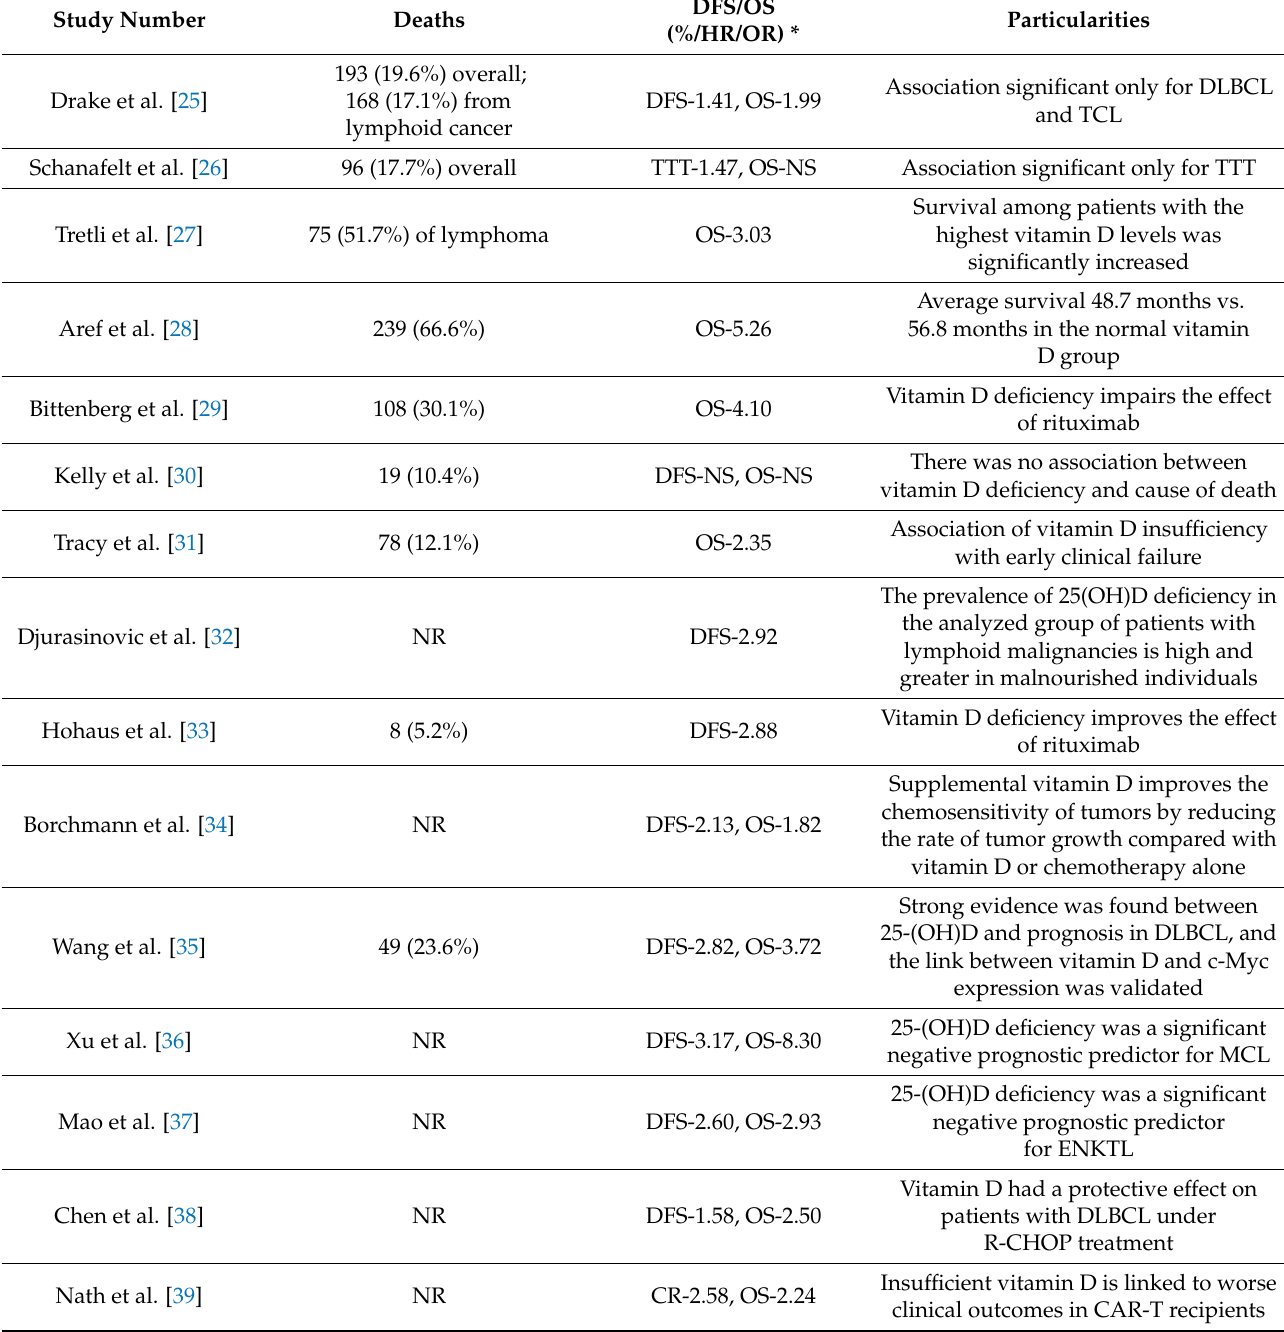
Table 4. Outcomes